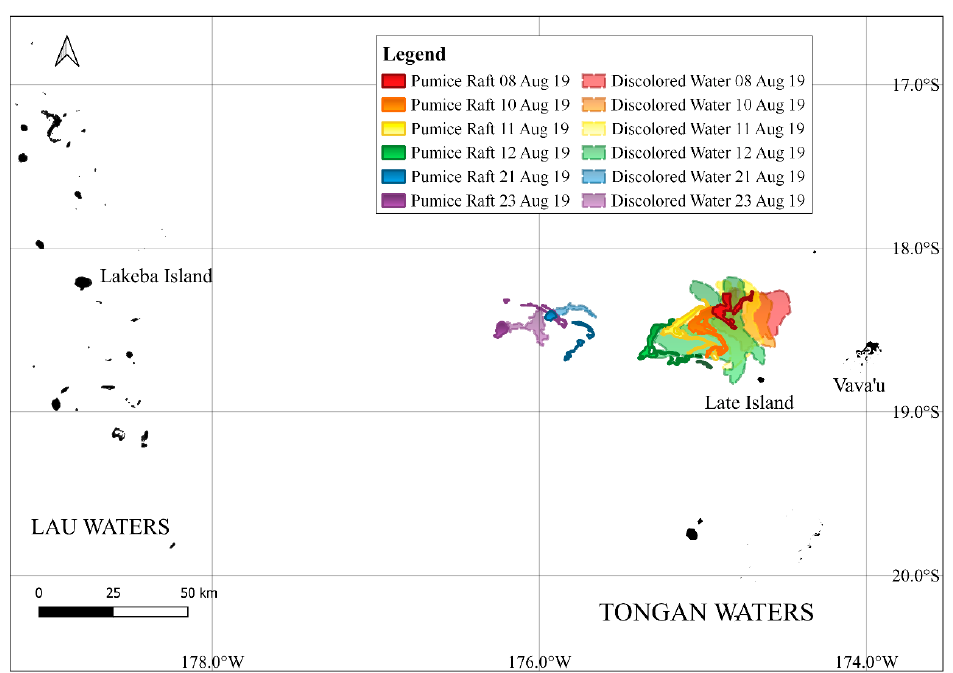
Figure 5. Map showing the combined drift of both pumice raft and discolored waters post-volcanic eruption between 8 and 23 August 2019. The pumice raft formed within the Vava’u group in Tongan Waters and drifted West toward Fiji by 23